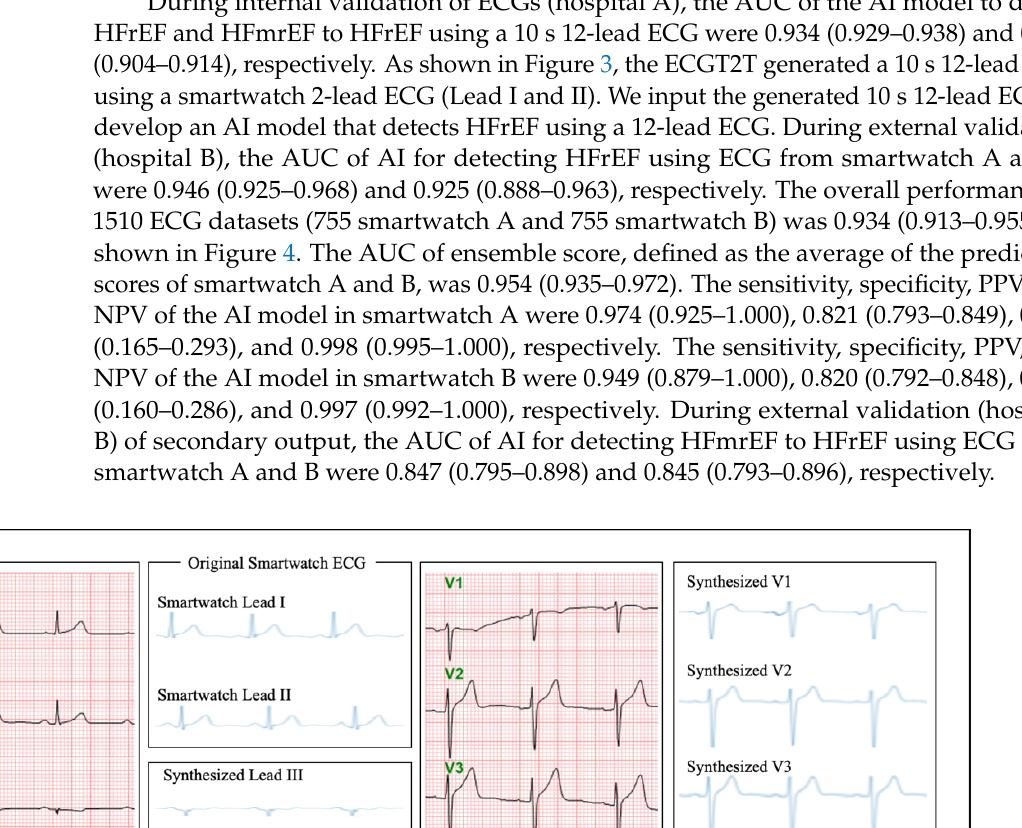
Figure 4. Performance of artificial intelligence for detecting heart failure using smart watch ECG. Legend: AUC denotes area under the receiver operating characteristic curve, CI confidence interval, ECG electrocardiography, NPV negative predictive value, PPV positive predictive value, SEN sen ‑ sitivity, and SPE specificity. Heart failure with reduced ejection fraction